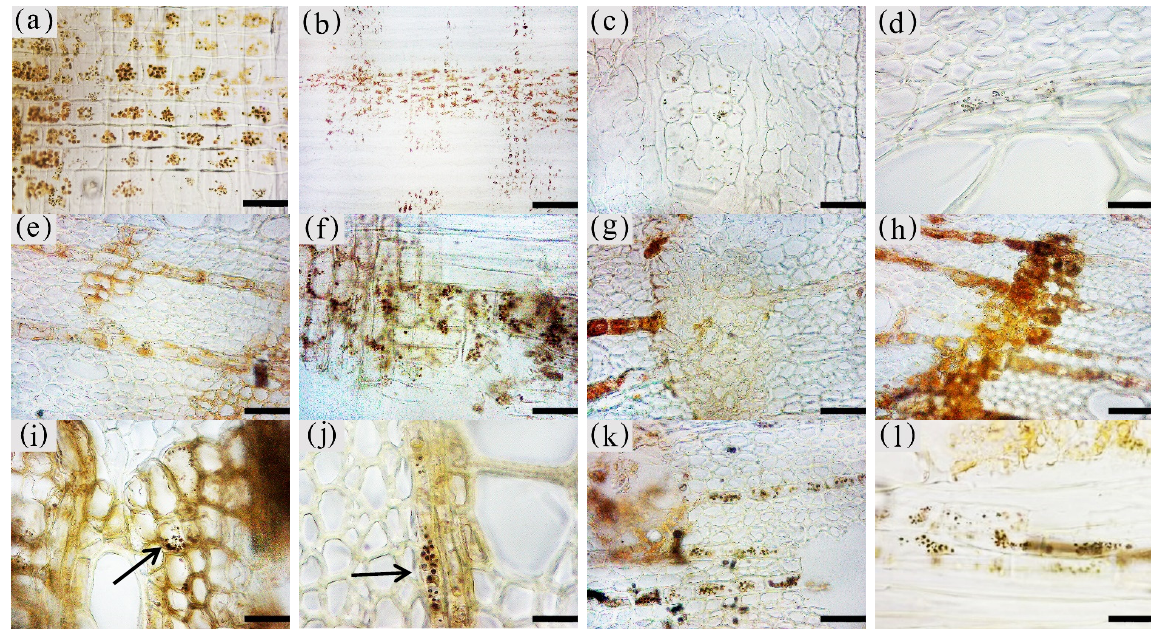
Figure 6. Color development of starch grains in xylem parenchyma cells of A. sinensis . ( a ) Starch grains in the blank control. ( b ) Starch grains in axial parenchyma and xylem rays in radial surface of white zone. ( c ) Starch grains in the interxylary phloem in the transverse surface of the white zone. ( d ) Starch grains in the medical wood rays in the transverse surface of the white zone. ( e ) Starch grains in the interxylary phloem in the transverse surface of the transition zone. ( f ) Some of the xylem rays and axial parenchyma in the radial surface of the transition zone contain starch grains. ( g ) No starch grains in the medialis of the interxylary phloem in transition zone. ( h ) Most parenchyma cells without starch grains in the transverse surface of the agarwood zone. ( i ) Starch grains in some of the interxylary phloem in the transverse surface of the agarwood zone. ( j ) Starch grains in some of the interxylary phloem in the transverse surface of the agarwood zone. ( k ) Starch grains in some of the interxylary phloem in the transverse surface of the decay zone. ( l ) Starch grains in some of the interxylary phloem in the radial surface of the decay zone. Scale bars = ( c , e – i , k , l ) 50 µ m; ( b )200 µ m; ( a , d , j ) 25 µ m.